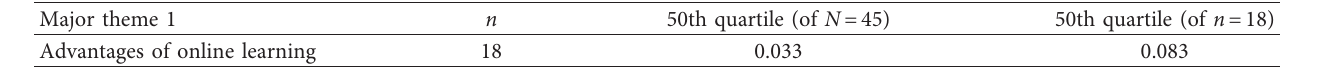
Table 3: 50th quartiles for advantages of online